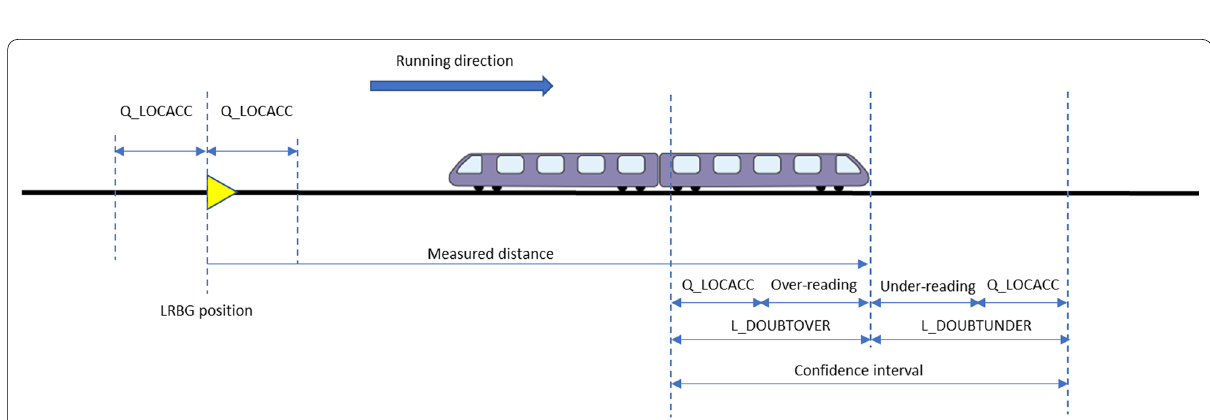
Fig. 6 Principles for ETCS train positioning